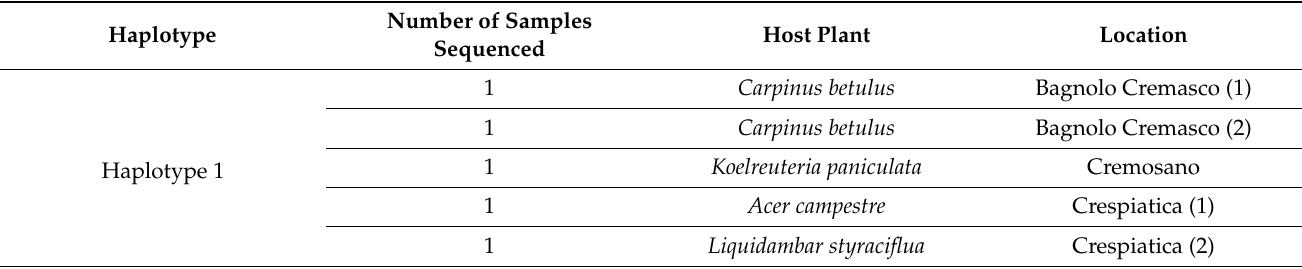
Table 4. Distribution and abundance of S. rubrocinctus haplotypes in relation to host-plant and location. GenBank accession numbers related to the COI sequences of the analysed samples are